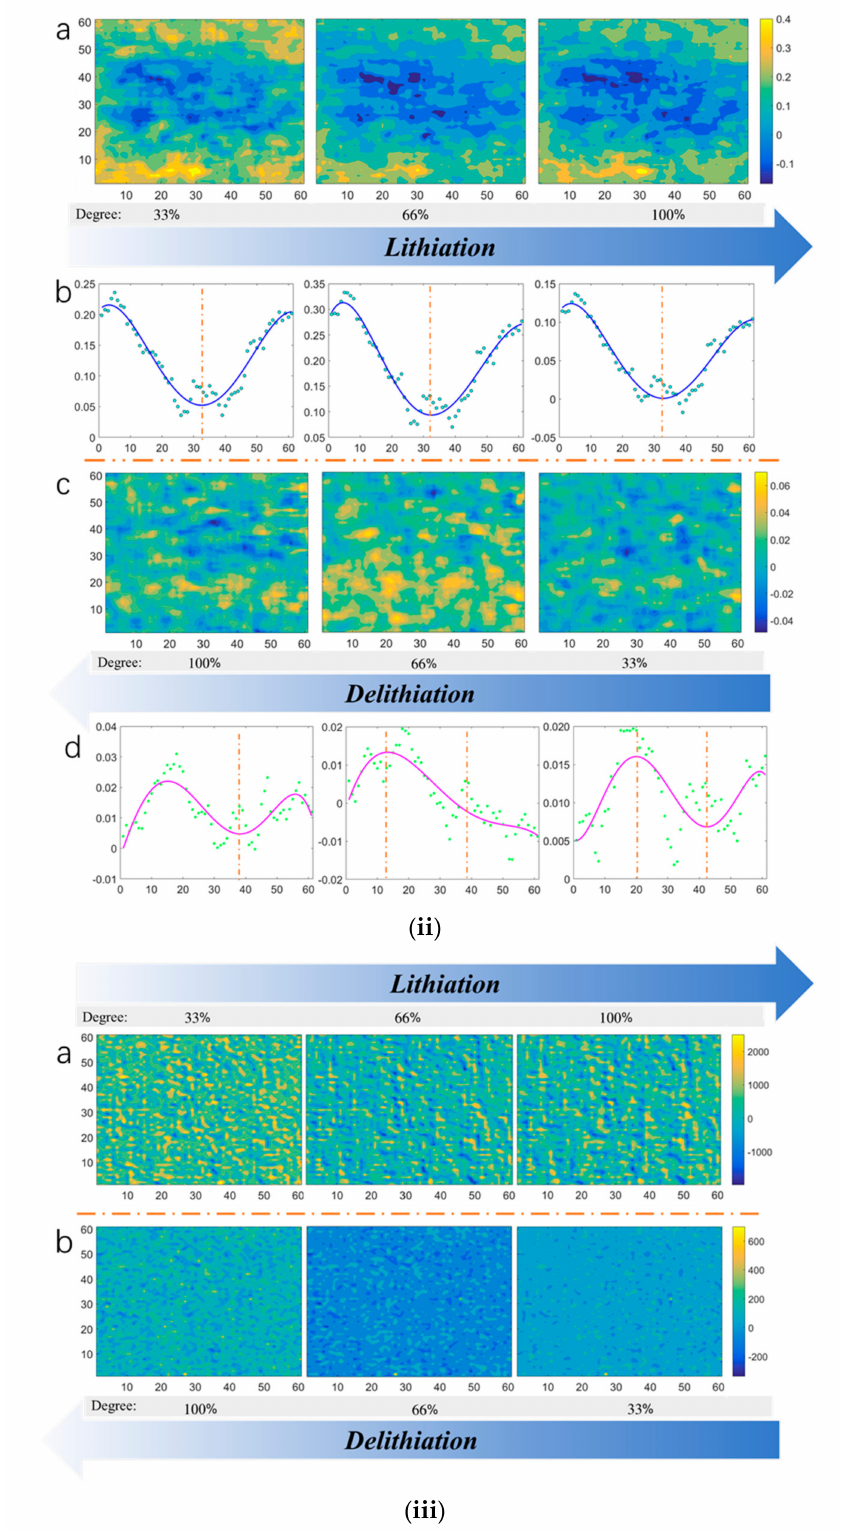
Figure 4. Electrode deformation distributions of sample during the first electrochemical cycle. ( i ) The strain distribution ε xx shows the radial strain distribution. ( ii ) The strain distribution ε yy shows strain distribution of the tangential direction accordingly. ( iii ) The out-of-plane displacement distribution w is